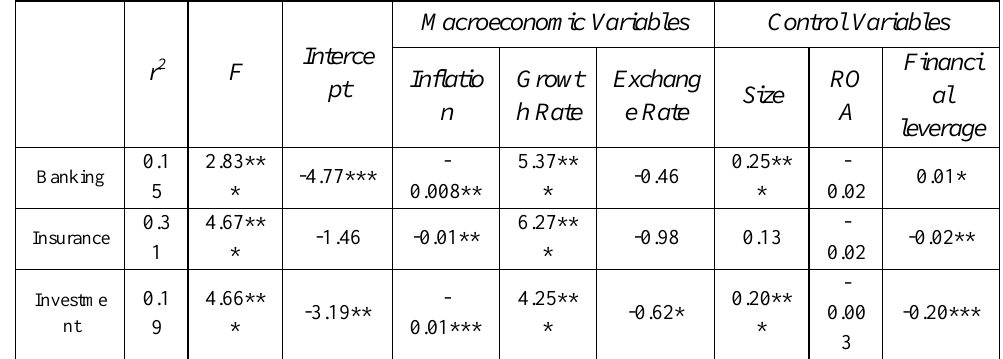
Table 9: Effect of macroeconomic variables on continuous beta